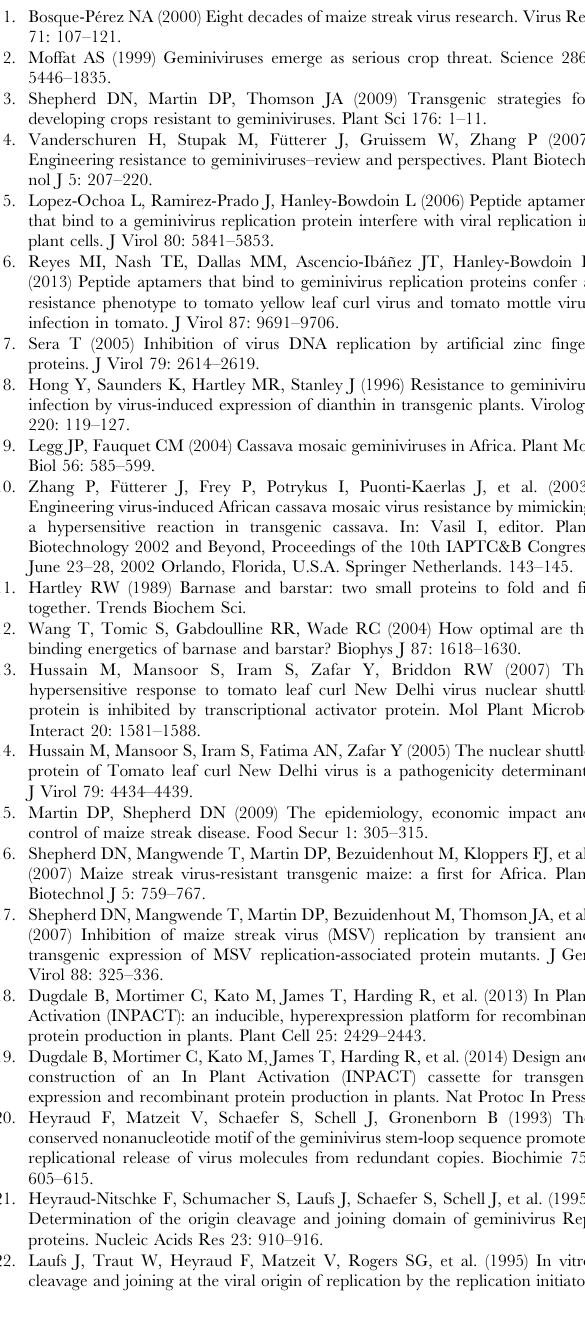
Figure S1 Annotated sequence of the synthesised